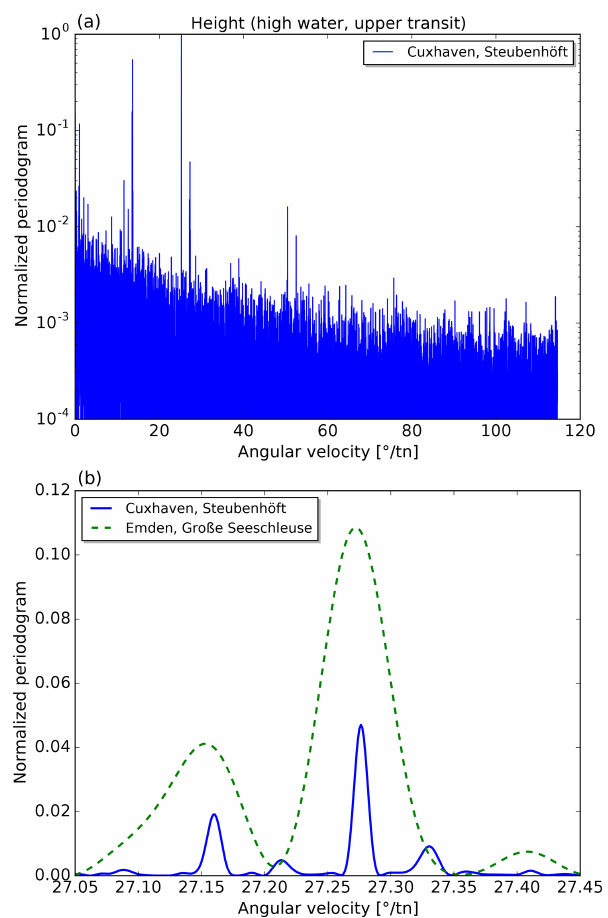
Figure 3. (a) Normalized periodogram of the heights of high wa- ters (assigned to upper lunar transits) for the tide gauge Cuxhaven. Notice the logarithmic scale. (b) Zoomed-in view of the region with the spectral line corresponding to half a tropical month (Mf) at 27.2764618 ◦ tn − 1 . The longer time series for Cuxhaven leads to narrower spectral lines (solid blue curve) compared to Emden (dashed green line).